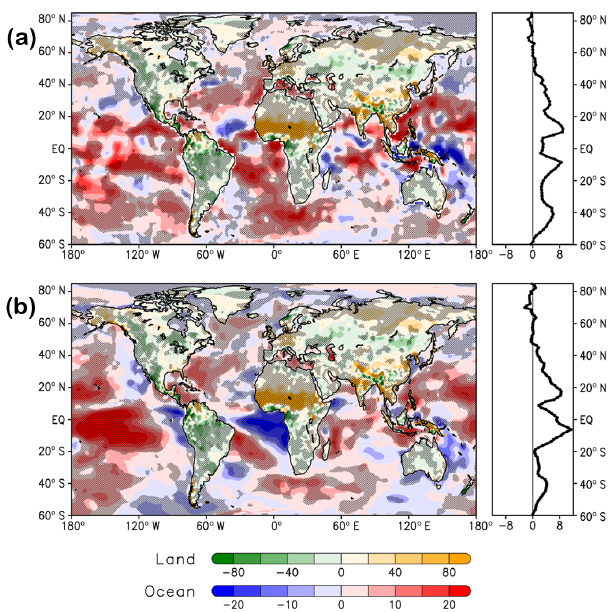
Figure 5. Global maps of the LHF trend shift over the oceans for (a) JAS-NCEP (Wm − 2 10 years − 1 ) and (b) JAS-JRA55. Land ar- eas display trend shifts in JAS precipitation from Fig. 3a. Shading denotes δ tan θ . Hatching represents areas where trends changed sign between the two parts of the study period (tan θ 1 · tan θ 2 <0).